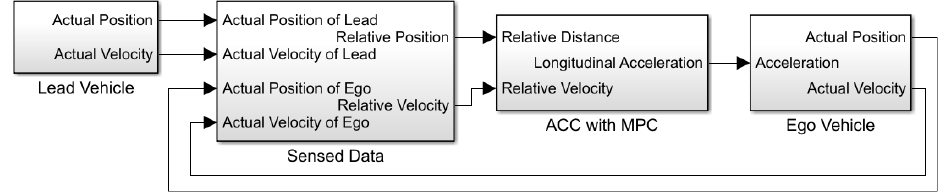
Figure 5. Adaptive cruise control